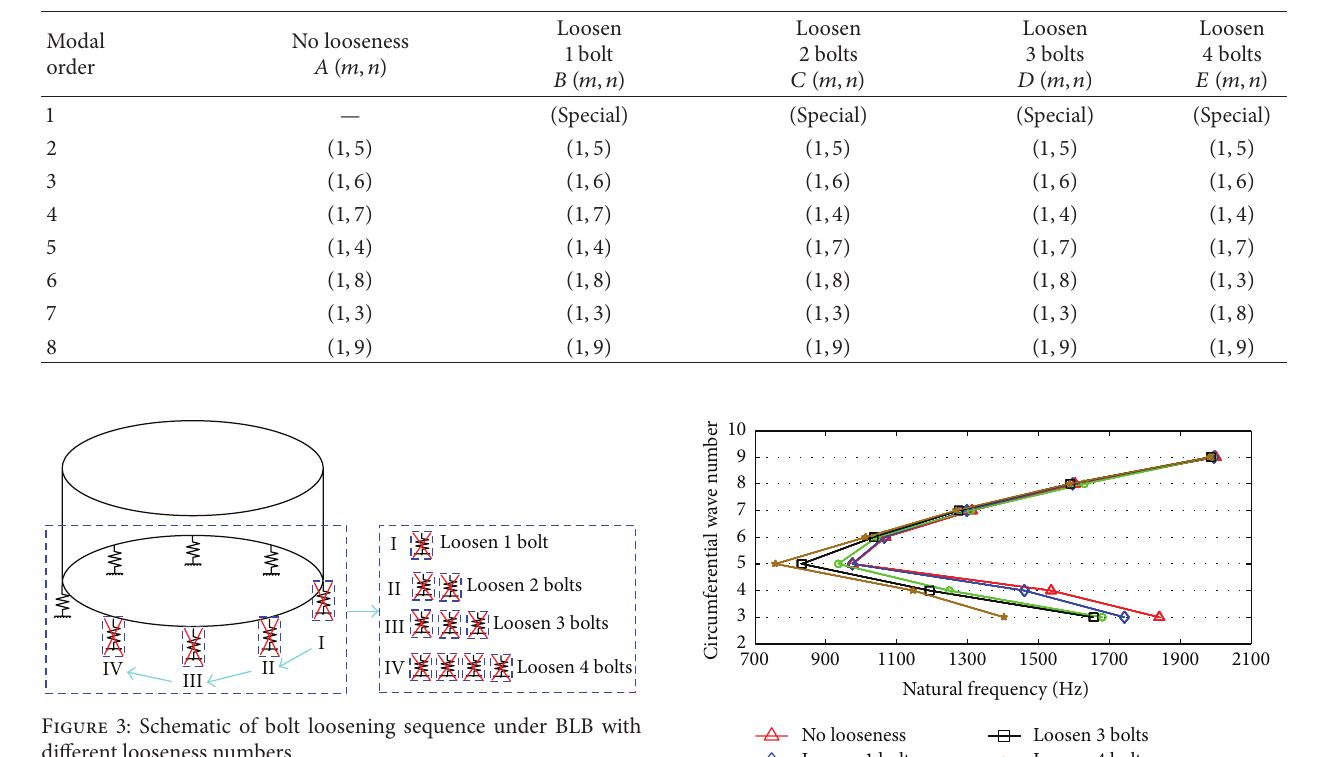
Table 3: Mode shapes of TCS under BLB with different looseness numbers.